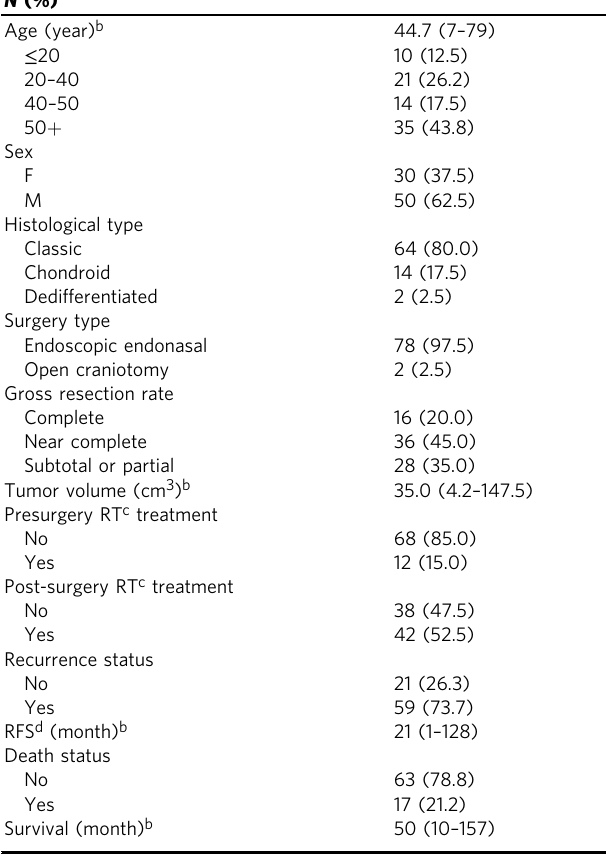
Table 1 Characteristics of chordoma patients included in the whole-genome sequencing analysis ( n = 80) a